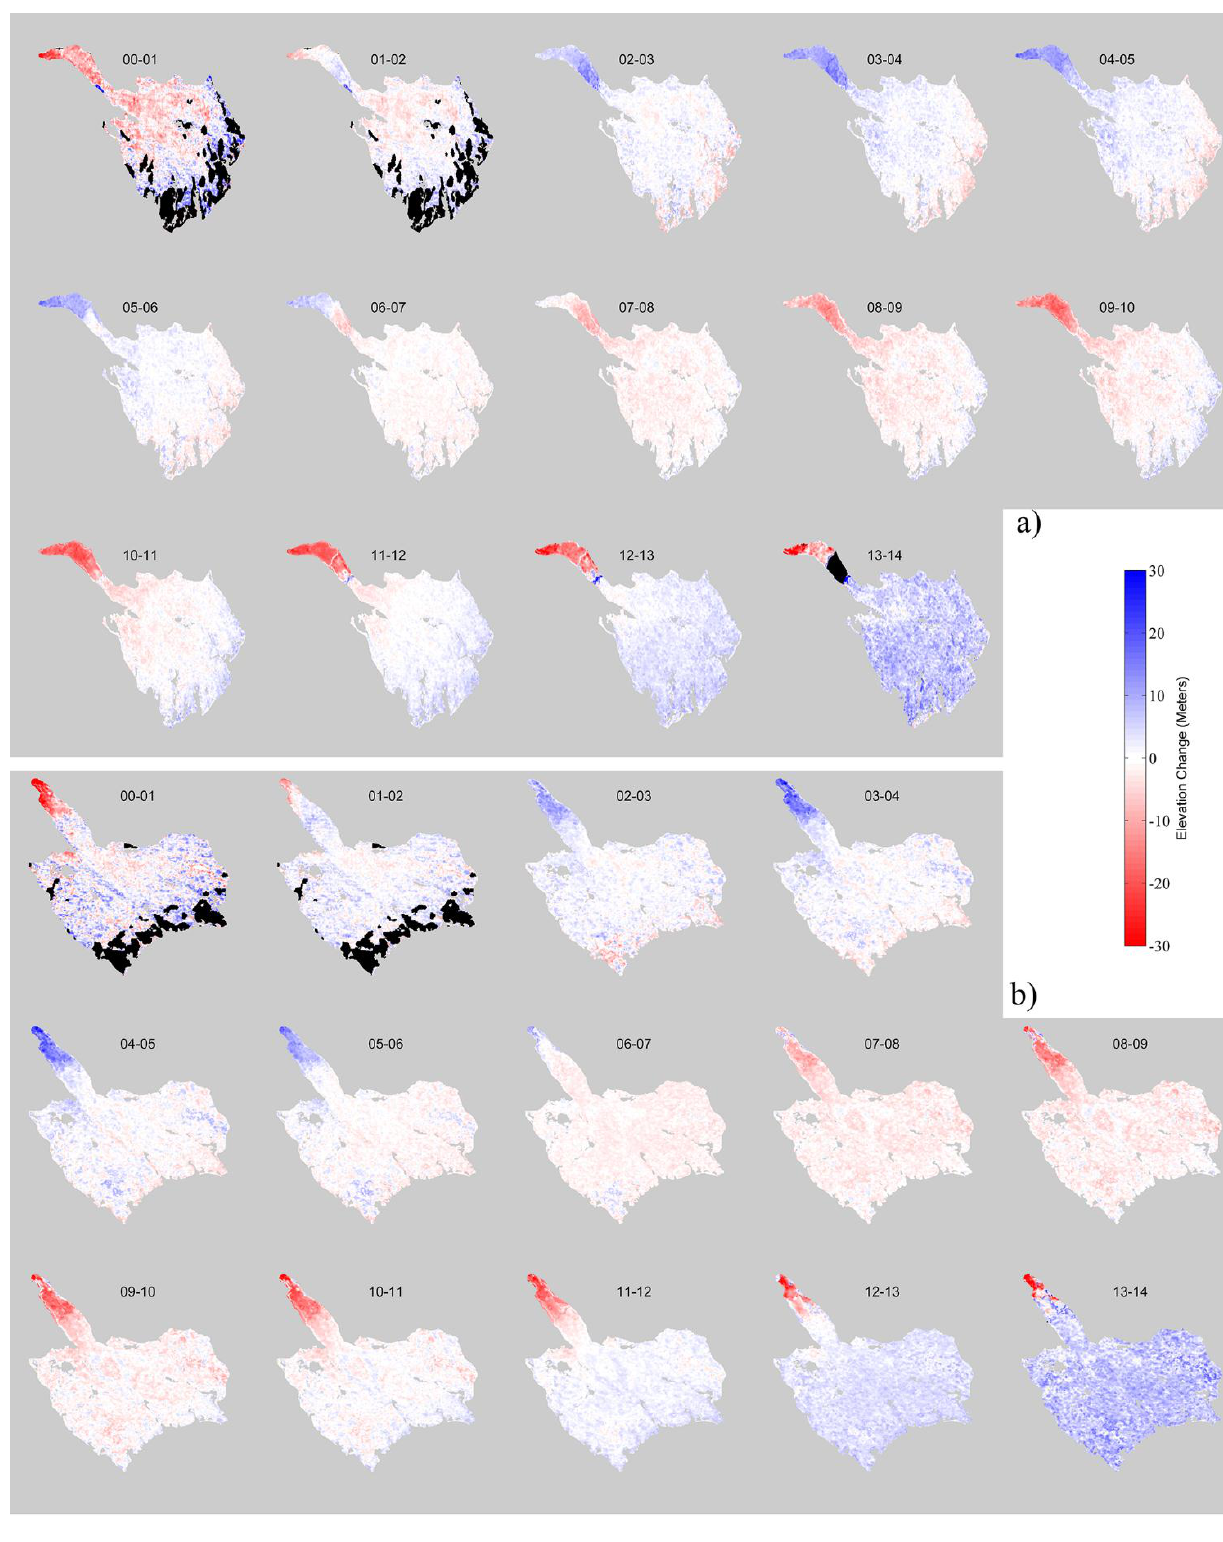
Figure 8. Annual elevation change of ( a ) Fox Glacier ( b ) Franz Josef Glacier, modelled by the tDEM method from DEM time series data. Untrusted results due to missing data at the boundaries of the time series are marked with black. Time periods refer to calendar years, i.e. , between 1 January of both